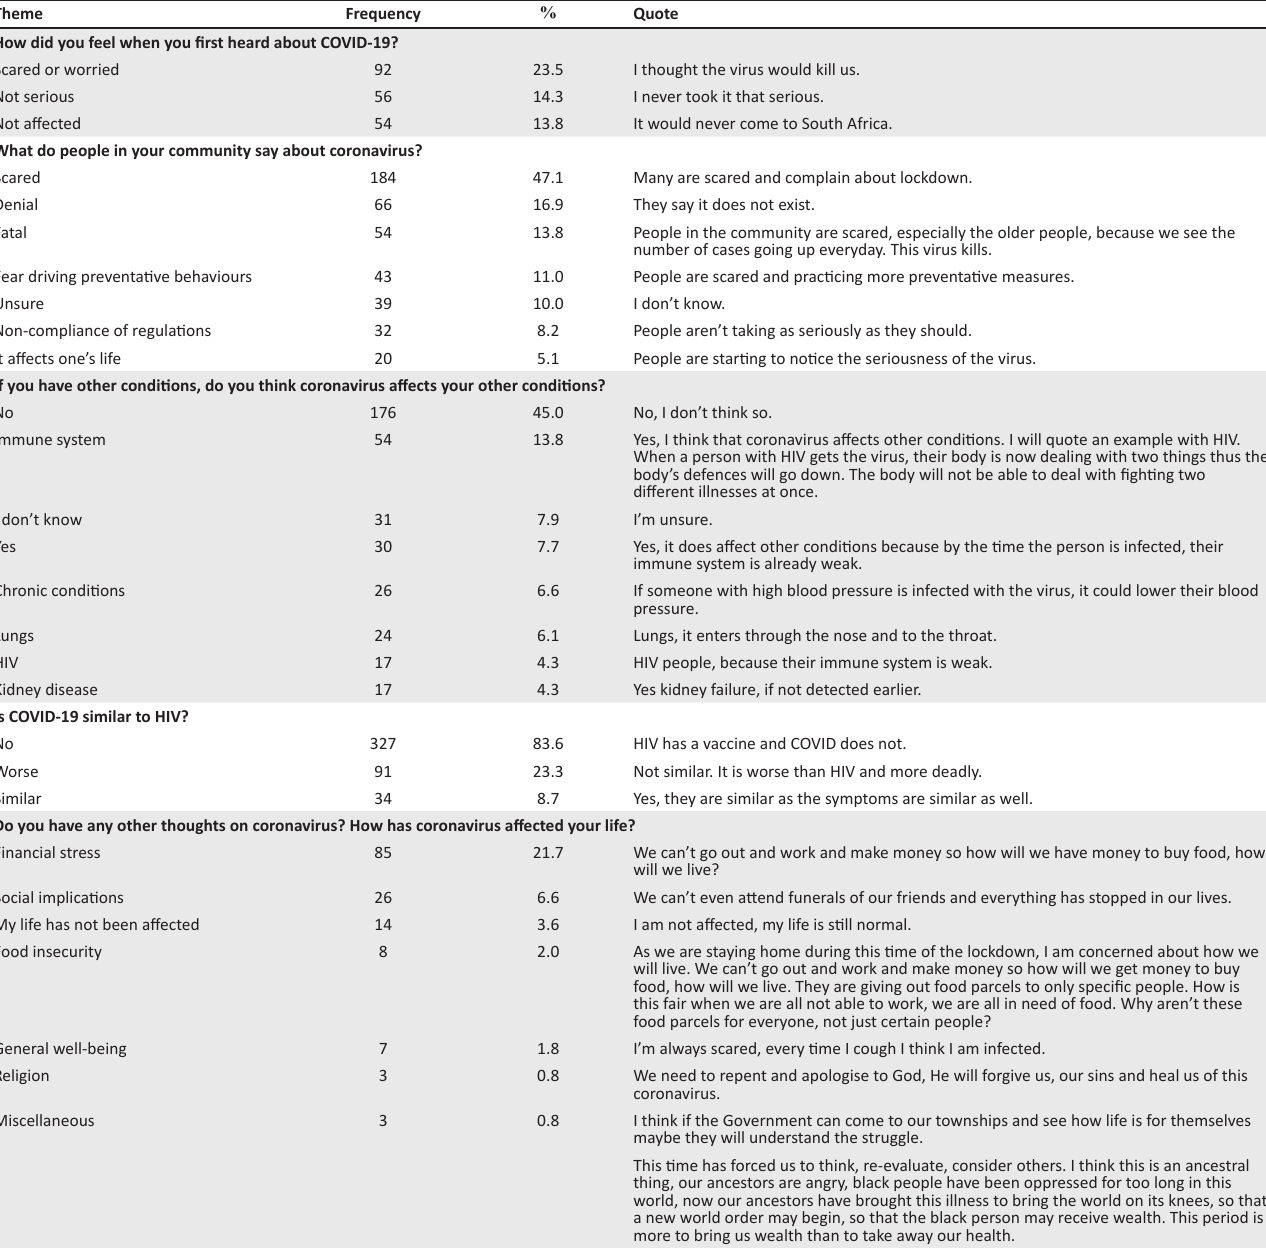
TABLE 3: Perception and experiences of COVID-19 and